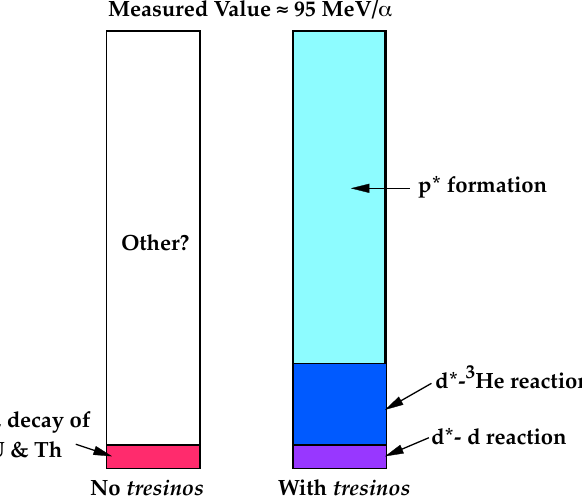
Fig. 7. A chart comparing the observed heat/helium data with and without tresino